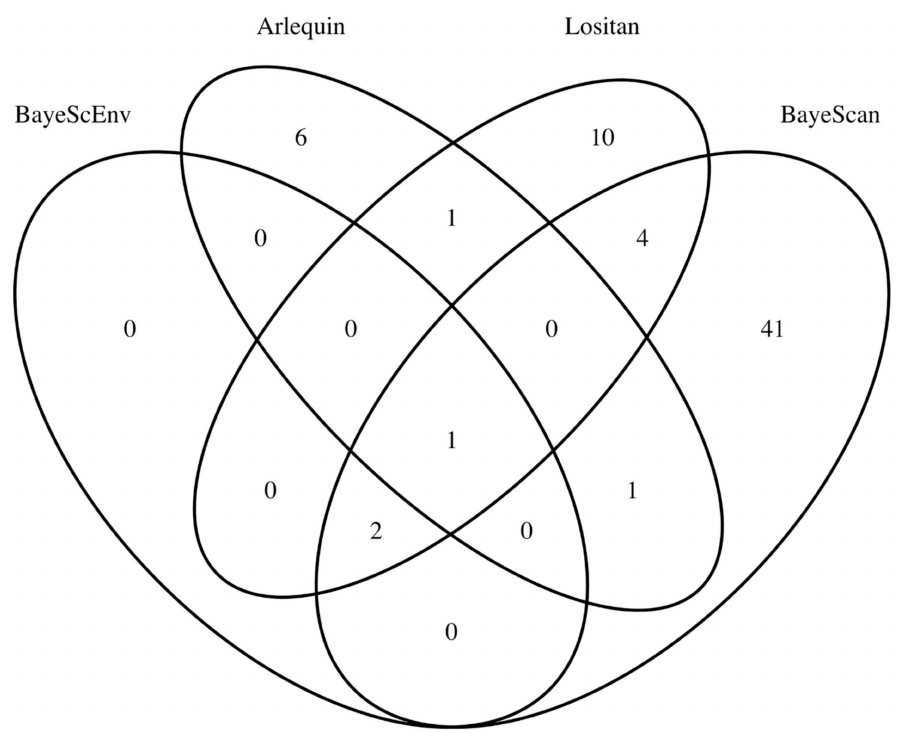
Figure 4. Venn diagram of the number of outlier SNPs detected using each method.